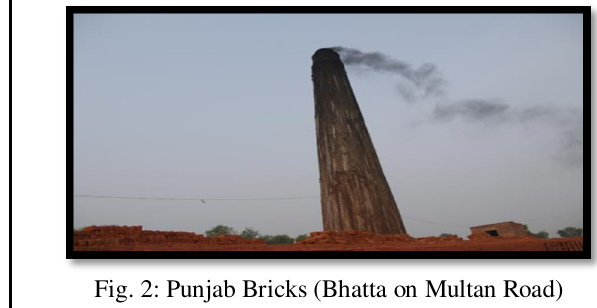
Fig. 2: Punjab Bricks (Bhatta on Multan